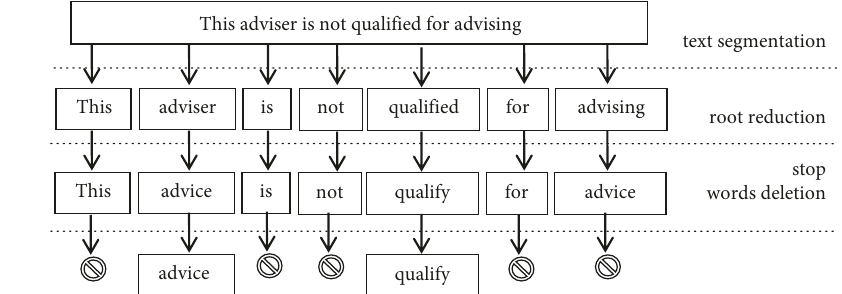
Figure 1: Text preprocessing typical